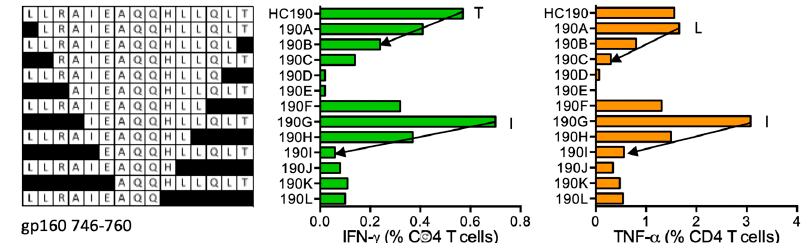
Figure 20. HC190/VID 414—definition of CD4 + T-cell epitopes in HIV-1 glycoprotein gp160. HC190 peptide-expanded PBMCs of VID 414 were incubated with truncated peptides (left) and frequencies of CD4 + T cells producing IFN- γ (green) and TNF- α (orange) were determined using polychromatic flow cytometry. Arrows and amino acids T, I and L indicate the stimulatory peptide termini. All CD4 + T cell epitope mapping data are summarized in Table 2.